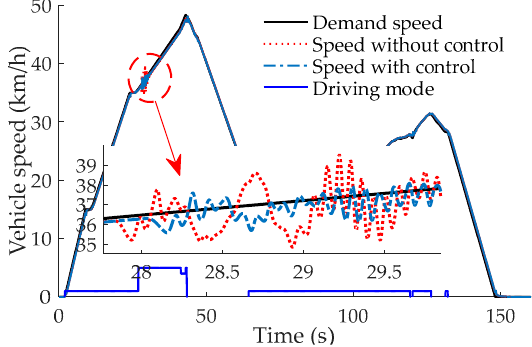
Figure 14. Vehicle speed and drive mode.